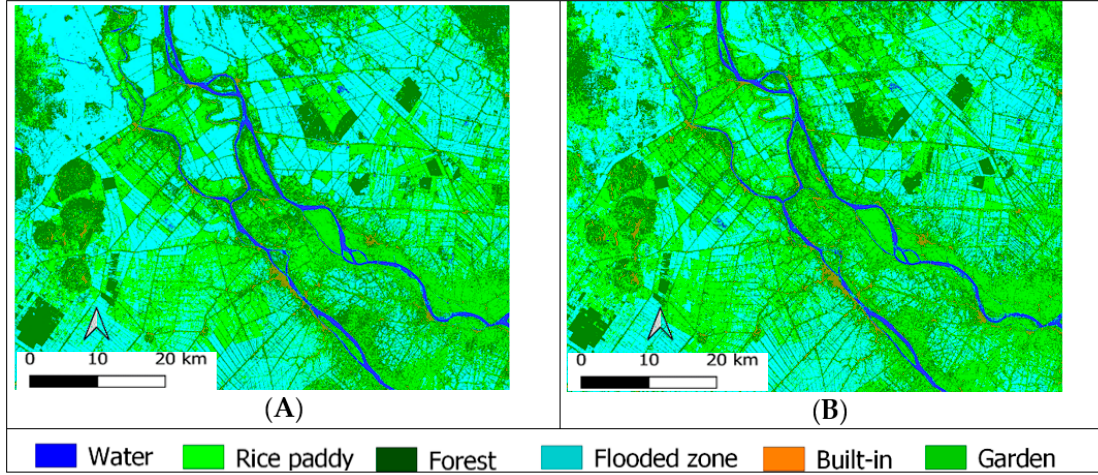
Figure 12. Land use/land cover (LULC) during the wet season ( A ) 2019 and ( B ) 2020 by CNN clas- sifier.